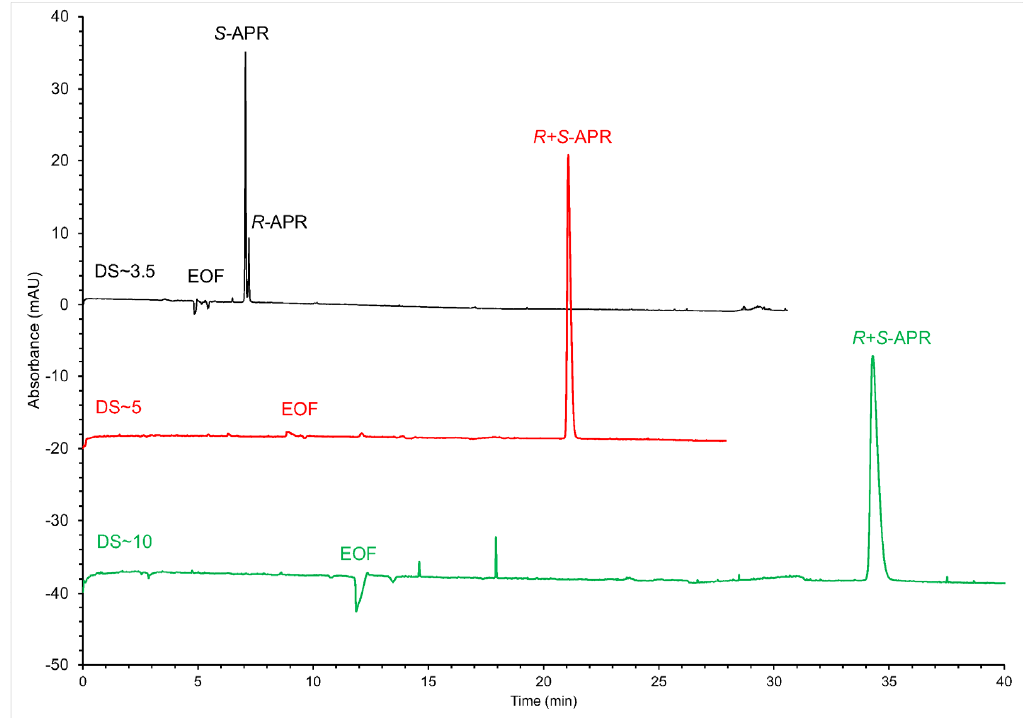
Figure 3. Enantioseparations of APR applying Succ- β -CD with different DS values. (CE conditions: 50 mM phosphate bu ff er pH 7.0, supplemented with 20 mM Succ- β -CD with the indicated DS; capillary temperature: 25 °C; hydrodynamic injection: 50 mbar × 2 s; detection: 210 nm and 20 kV).